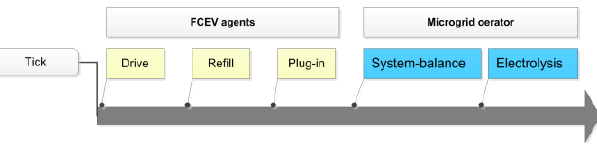
Figure 6. Procedures in